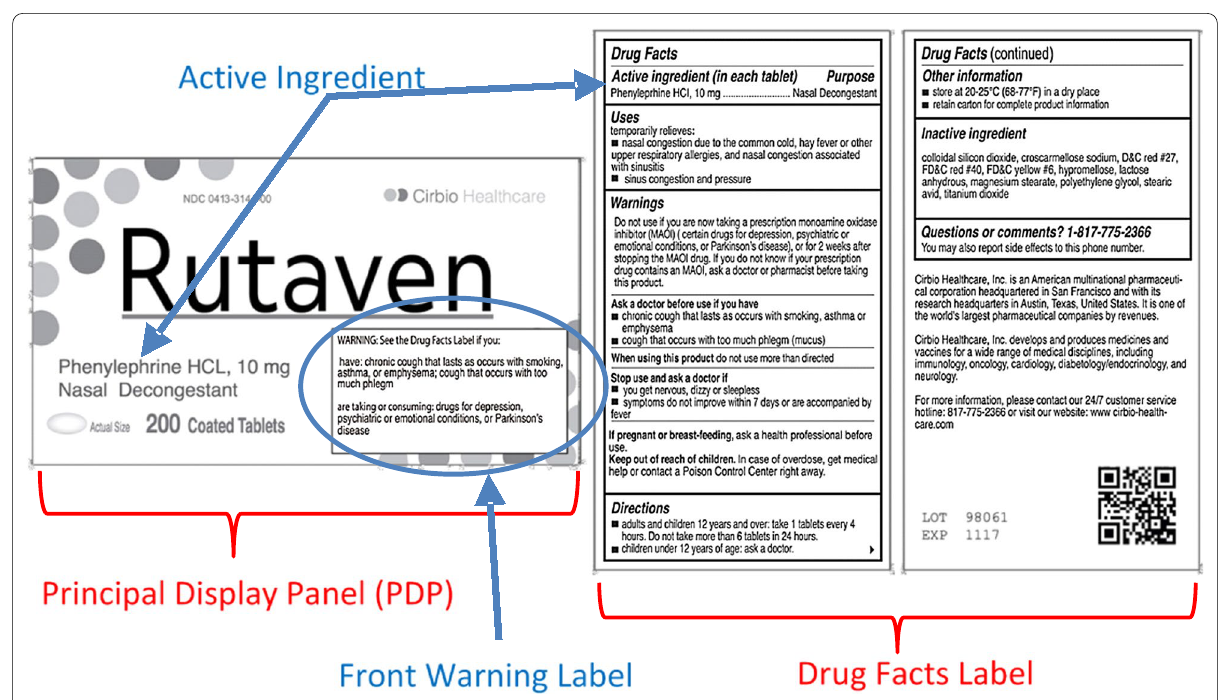
Fig. 1 An example of one of the mock brands. For illustrative purposes, the principle display panel (PDP) and Drug Facts Label are labeled in red and the front warning label and active ingredients are labeled in blue. The actual stimulus did not show these colored labels, arrows, and